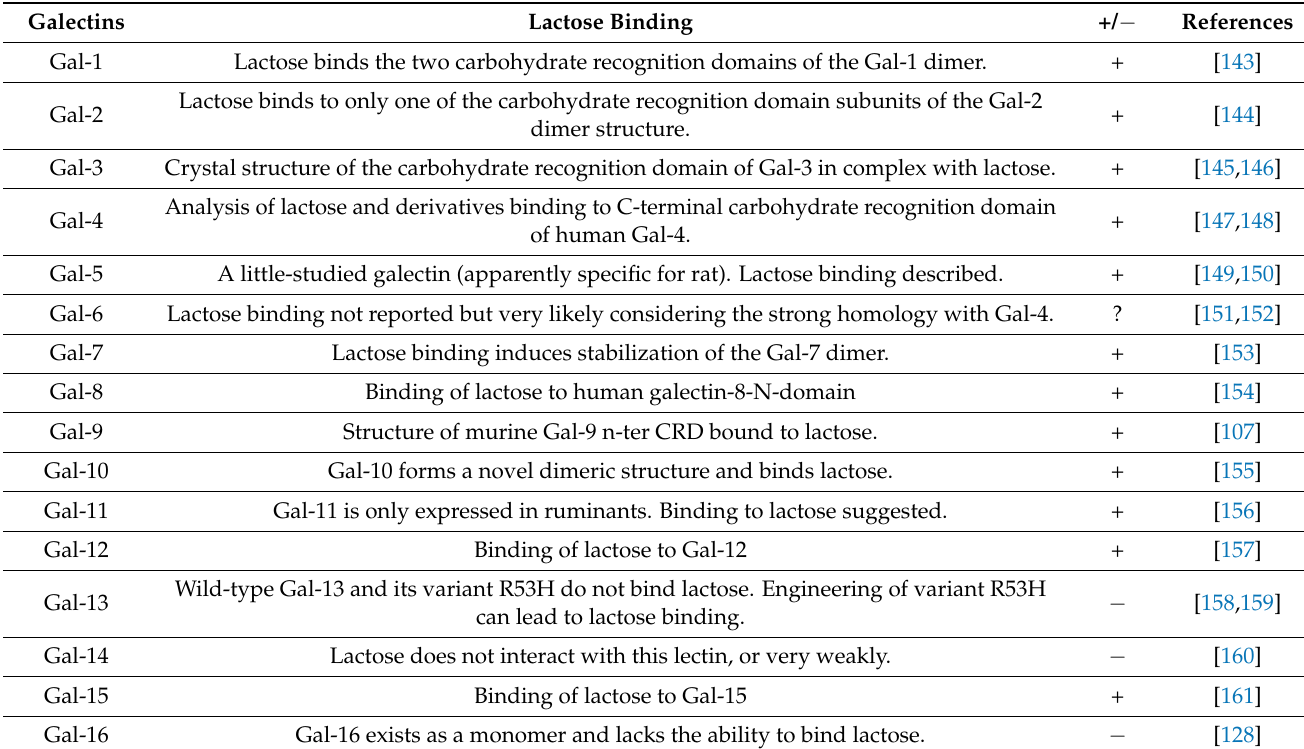
Table 2. Lactose binding to